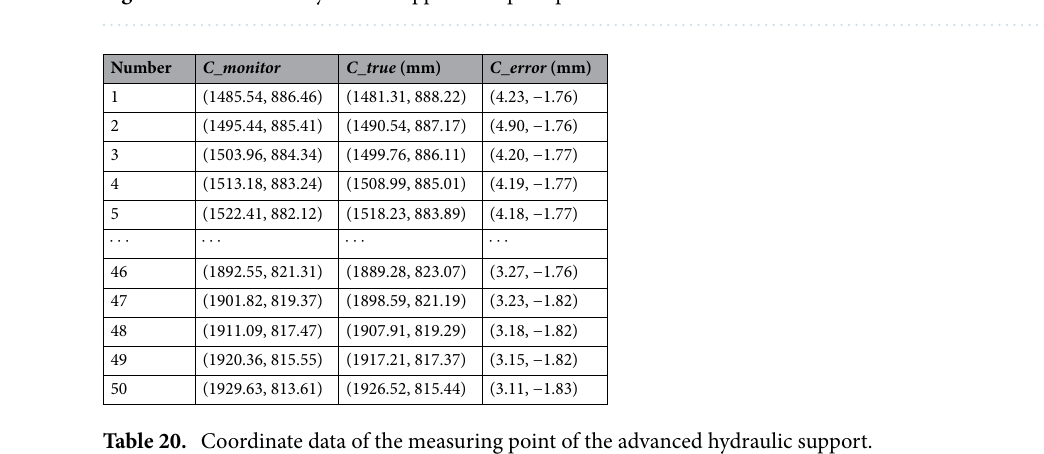
Figure 19. Advanced hydraulic support side push process.